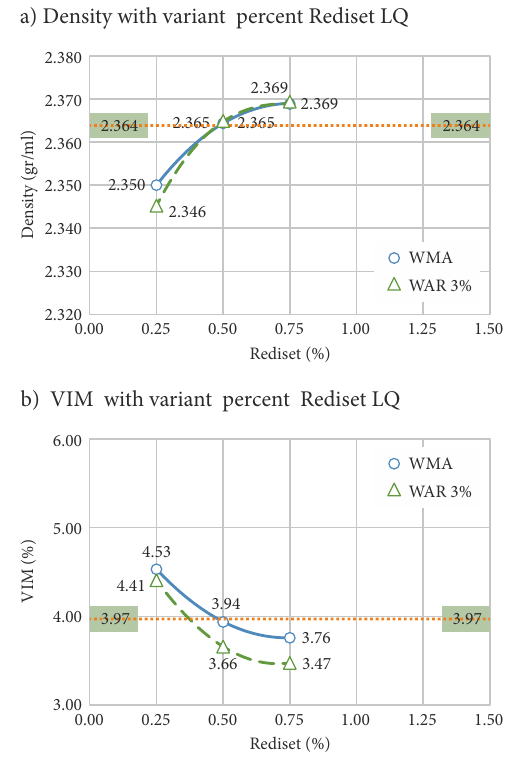
Figure 7. Density and VIM with variant percent of Rediset